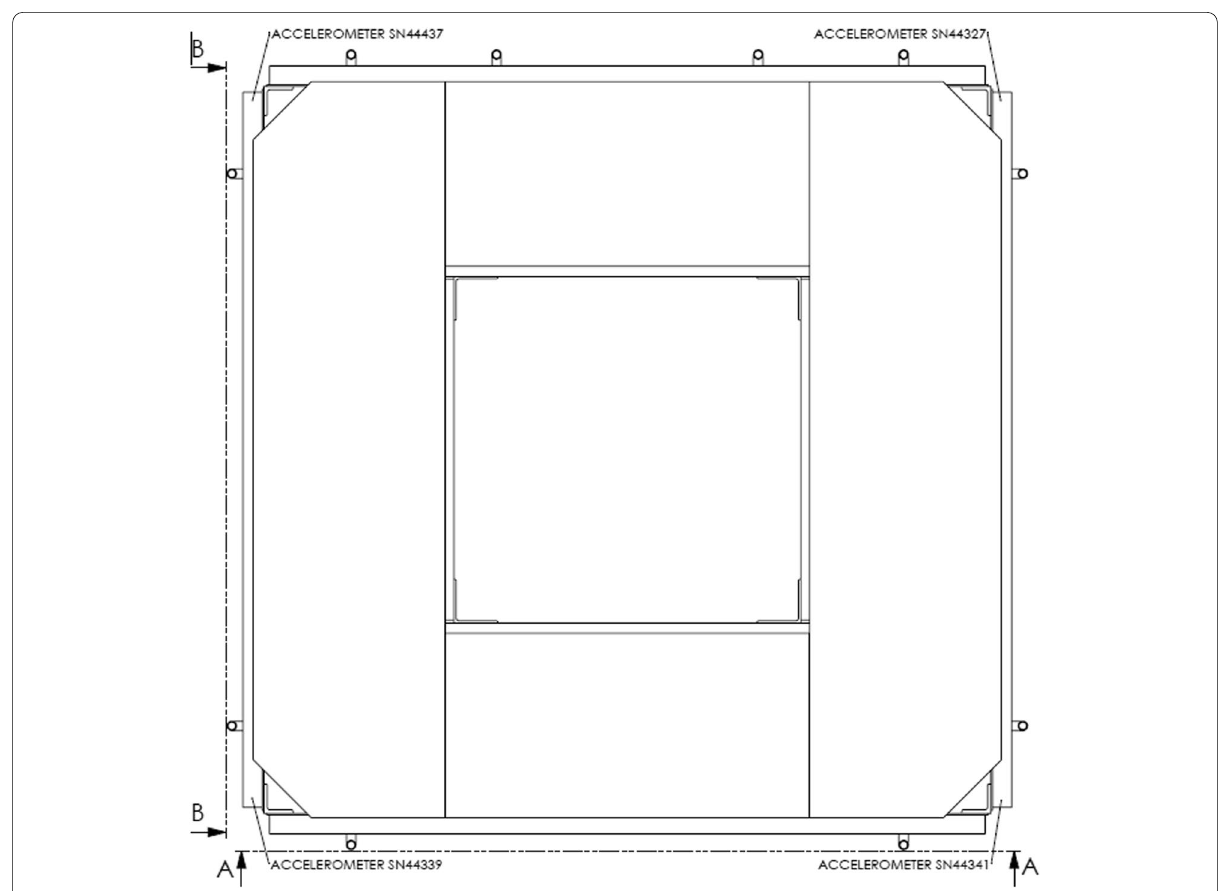
Fig. 3 Accelerometer mounted on the frame – vertical